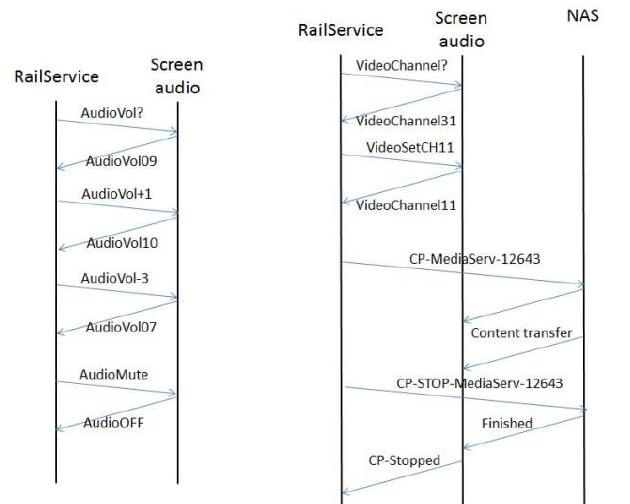
Figure 17. Some communication flows for the remote control of the